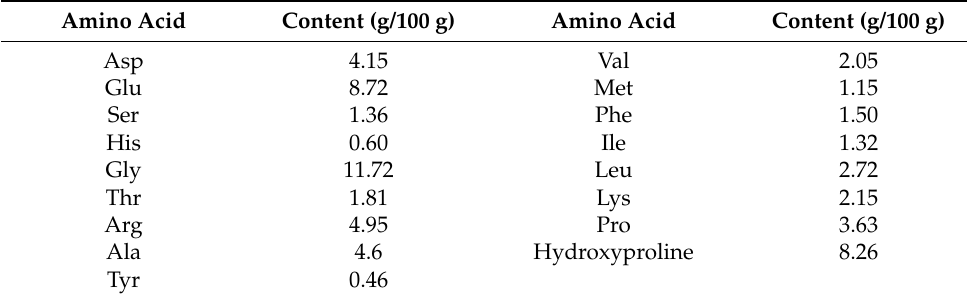
Table 2. Amino acid composition of UC II .